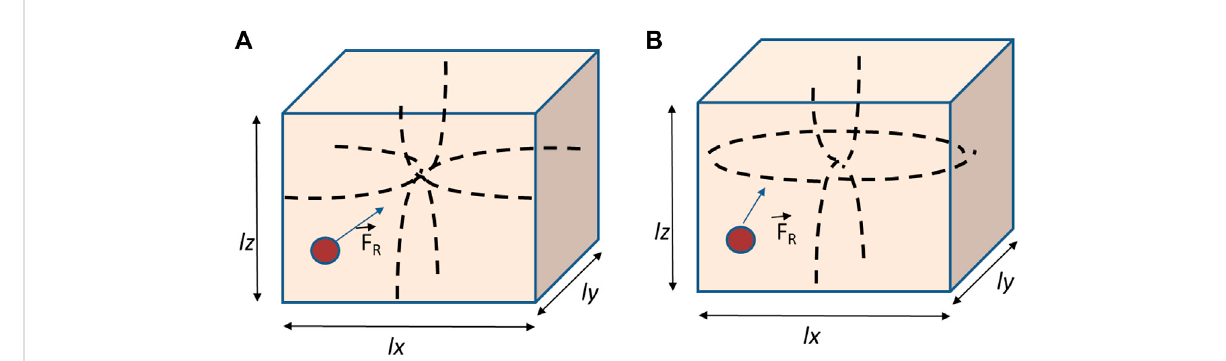
FIGURE 1 3D F R acting on a spherical particle within a rectangular chamber of dimensions l x , l y , and l z with a standing pressure fi eld p x (x), p y (y), and p z (z), respectively. (A) Chamber with all rigid walls; (B) rectangular chamber with free walls in